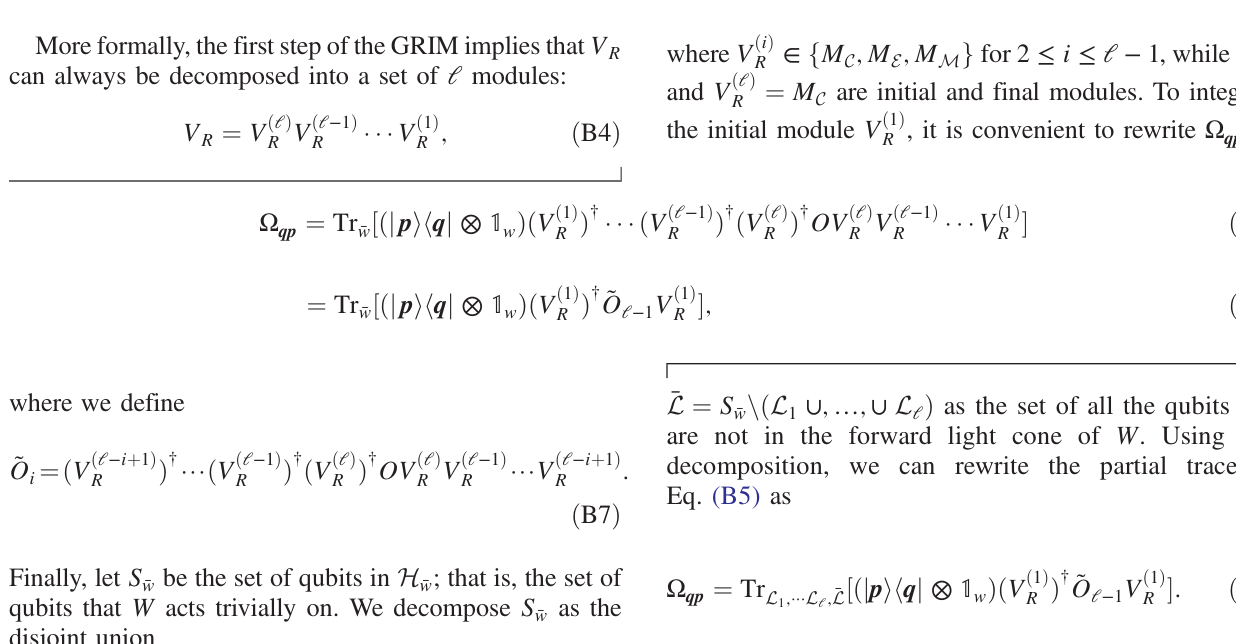
FIG. 8. Examples of the first step of the GRIM. Here we can cover all of the forward light cone L l times. Panels (a) and (b), respectively, correspond to the cases when the unitary W is in first sublayer and second sublayer of the l th QCNN layer. In all cases, W is indicated by a larger orange circle, and the forward light cone is shaded in yellow. For the panels in (a), W is not included in any module, while in (b) W belongs to the first module M